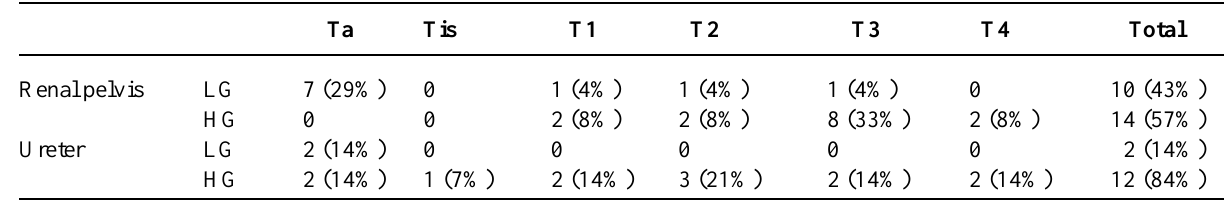
Table 2 – Distribution of renal pelvis and ureteral tumors according to histologic grade and